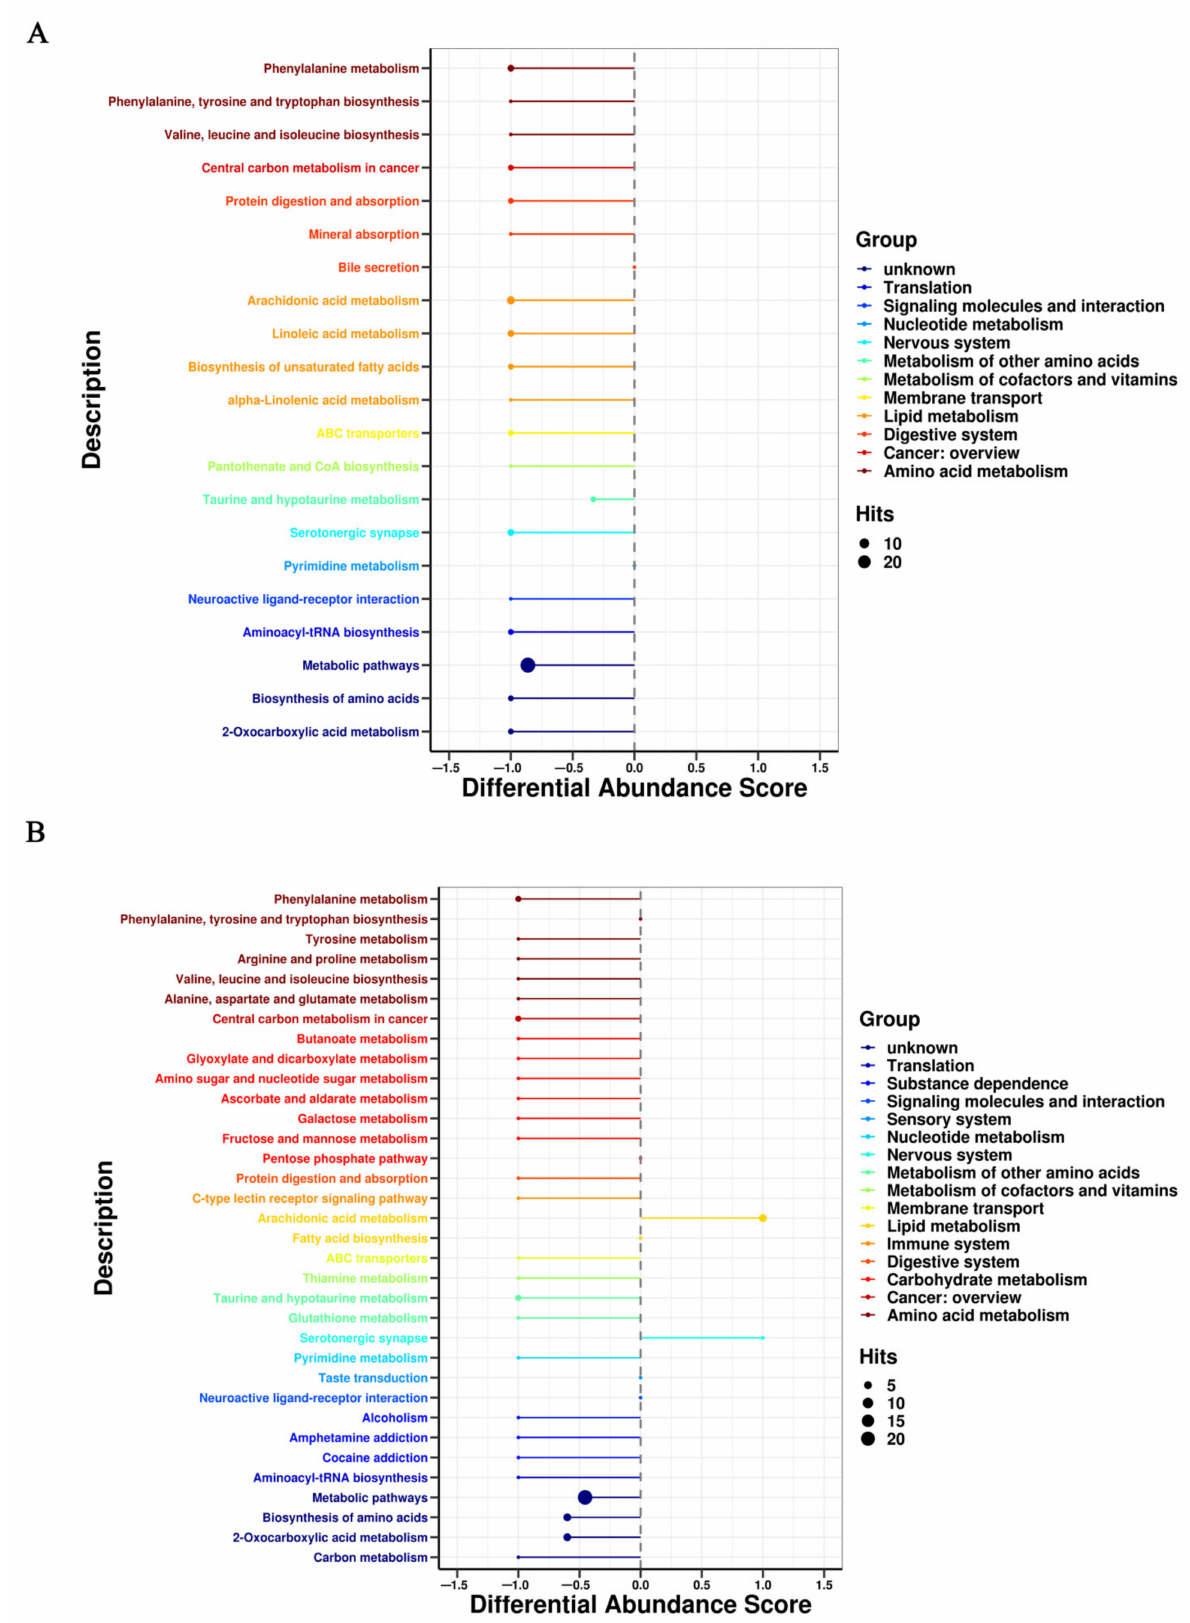
Figure 4. The disturbed pathway analysis using DA score in the ESI- mode. ( A ) HF versus CT group. ( B ) HF4H versus HF